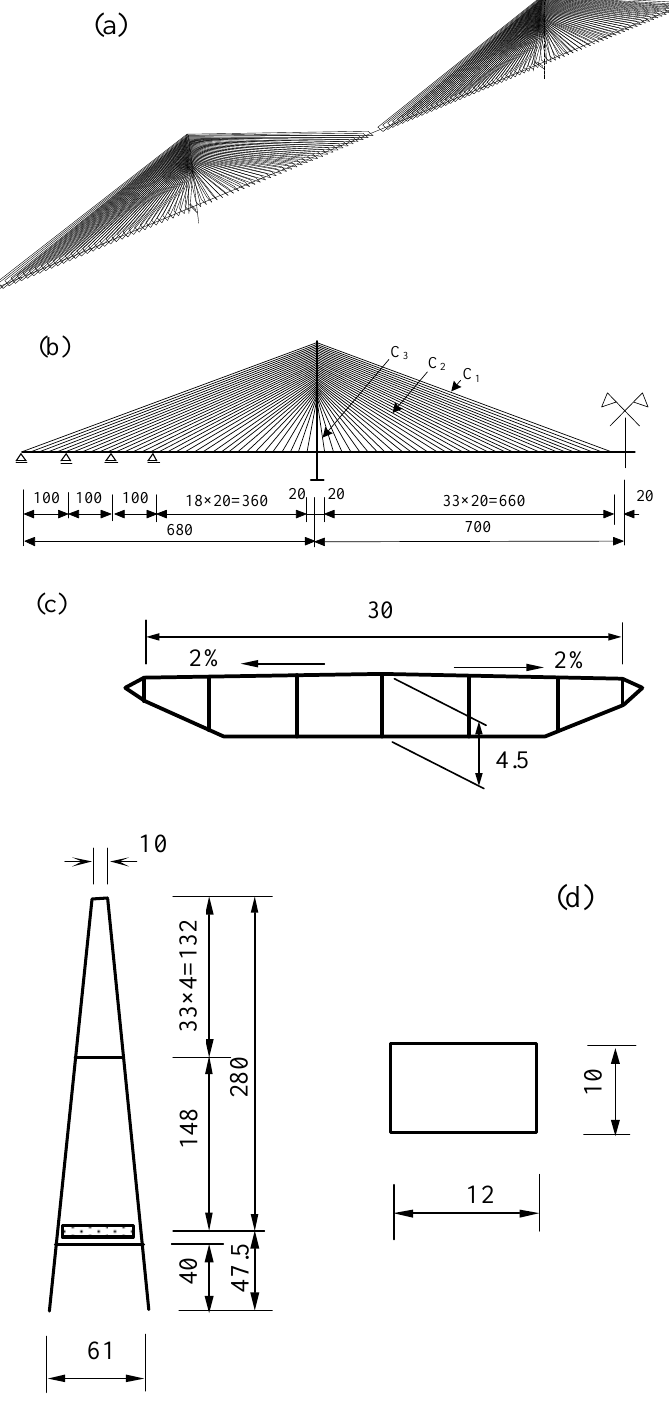
Figure 5. ( a ) 3D model of the bridge; ( b ) layout of half of the bridge; ( c ) typical cross-section of the box girder; ( d ) layout of the pylon and cross-section of the